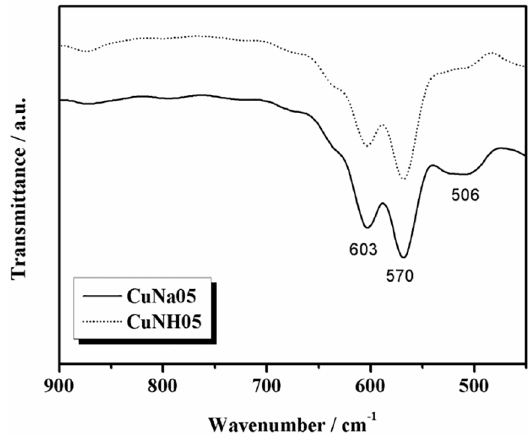
Figure 3. IR spectra of the CuNa05 and CuNH05 samples obtained at 130 °C for 5 minutes.